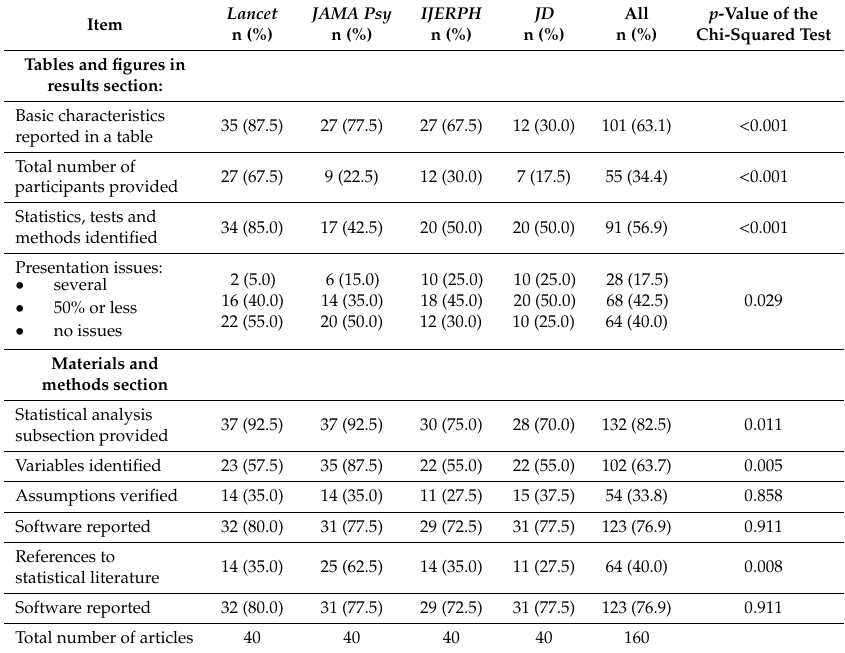
Table 4. The distributions of the data analysis reporting test items by the